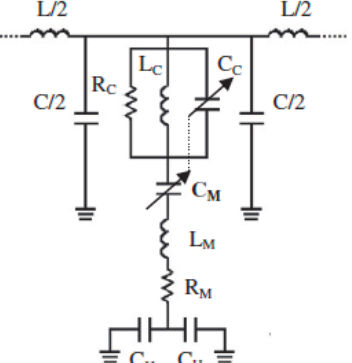
Figure 5. Lumped element equivalent circuit (unit cell) of the CSRR/RF-MEMS based stopband filter, including losses. From [18], reprinted with permission.